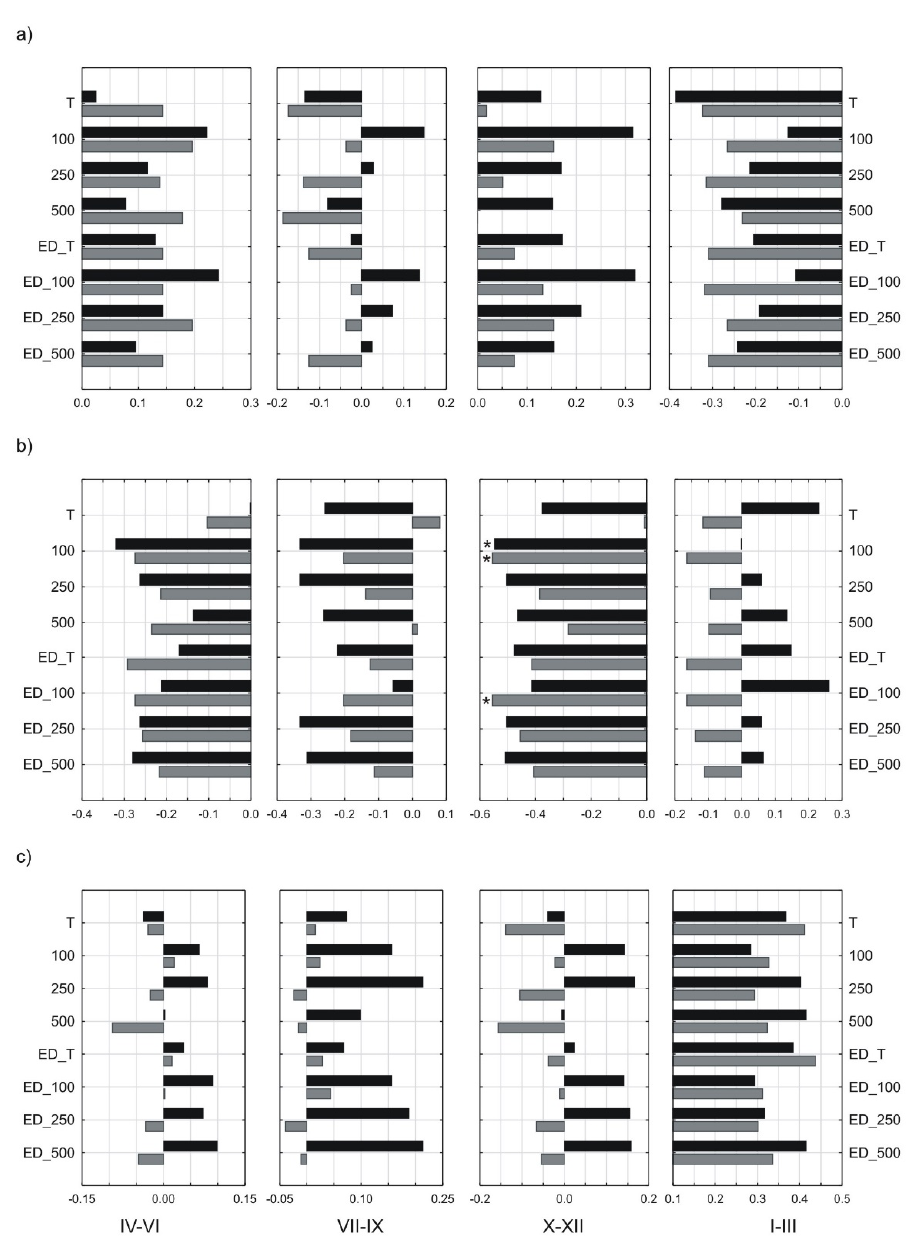
Figure 6. Correlation coefficients between P-PO 4 concentration in certain seasons and different land cover metrics calculated for agricultural lands ( a ), meadows ( b ), and forests ( c ) with the use of the CLC 2018 and S2GLC datasets, respectively. Abbreviations: T, total catchment area; 100, 250, and 500, width of the buffer zone; ED, metrics computed with the Euclidean distance scaling. The * indicates significant correlation at p = 0.05.